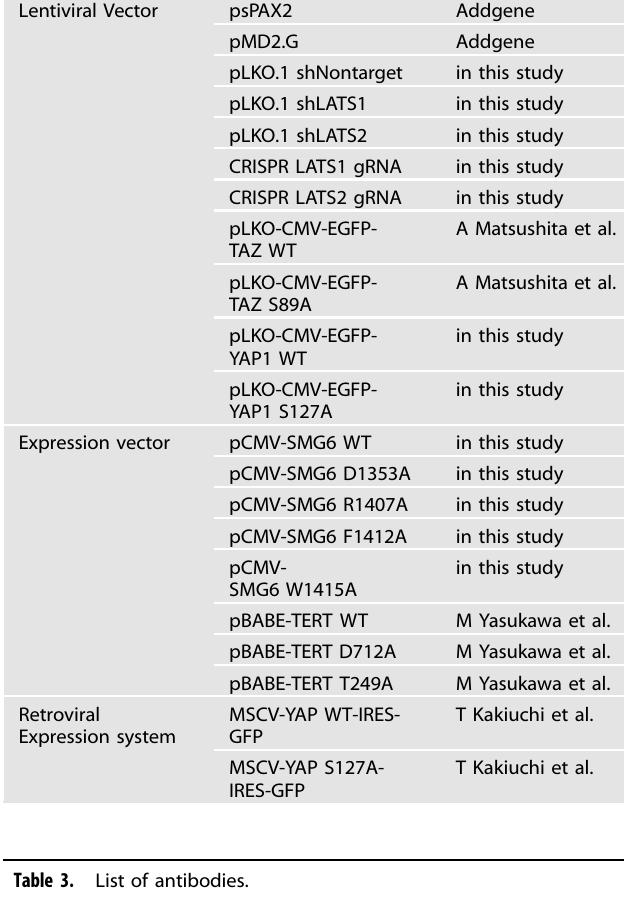
Table 2. List of plasmids.